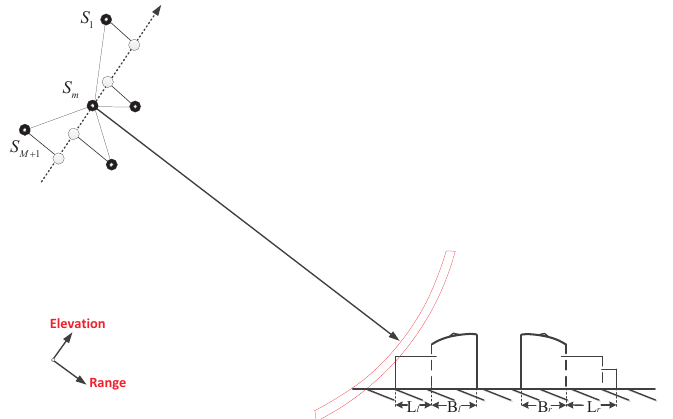
Figure 10. SAR acquisition geometry along the S profile in range and elevation plane marked in top-left sub-image of Figure 3. L l and L r represent lounge bridges of both sides, and B l and B r represent the symmetric main structure of the T3 E building.